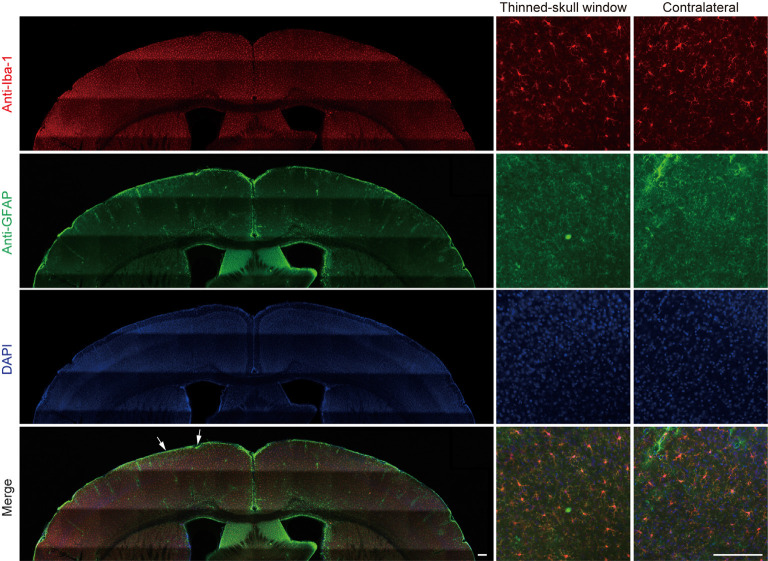
No obvious glial activation is observed under the thinned-skull window. Two days after thinning-skull surgery in 20-month-old mice, iba1-stained microglia appeared normal both on the contralateral control side and under the thinned-skull window. Little GFAP expression was found under the thinned-skull window (between arrows) or on the contralateral control side. Scale bar, 200 μm.